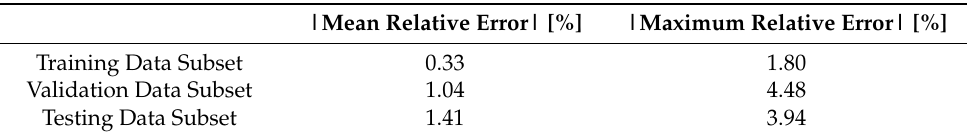
Table 1. The mean and maximum values of the relative